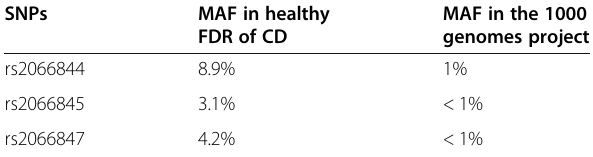
Table 1 Minor allele frequency of NOD2 risk SNPs in healthy FDR of CD patients in comparison to the MAF in the 1000 genome project